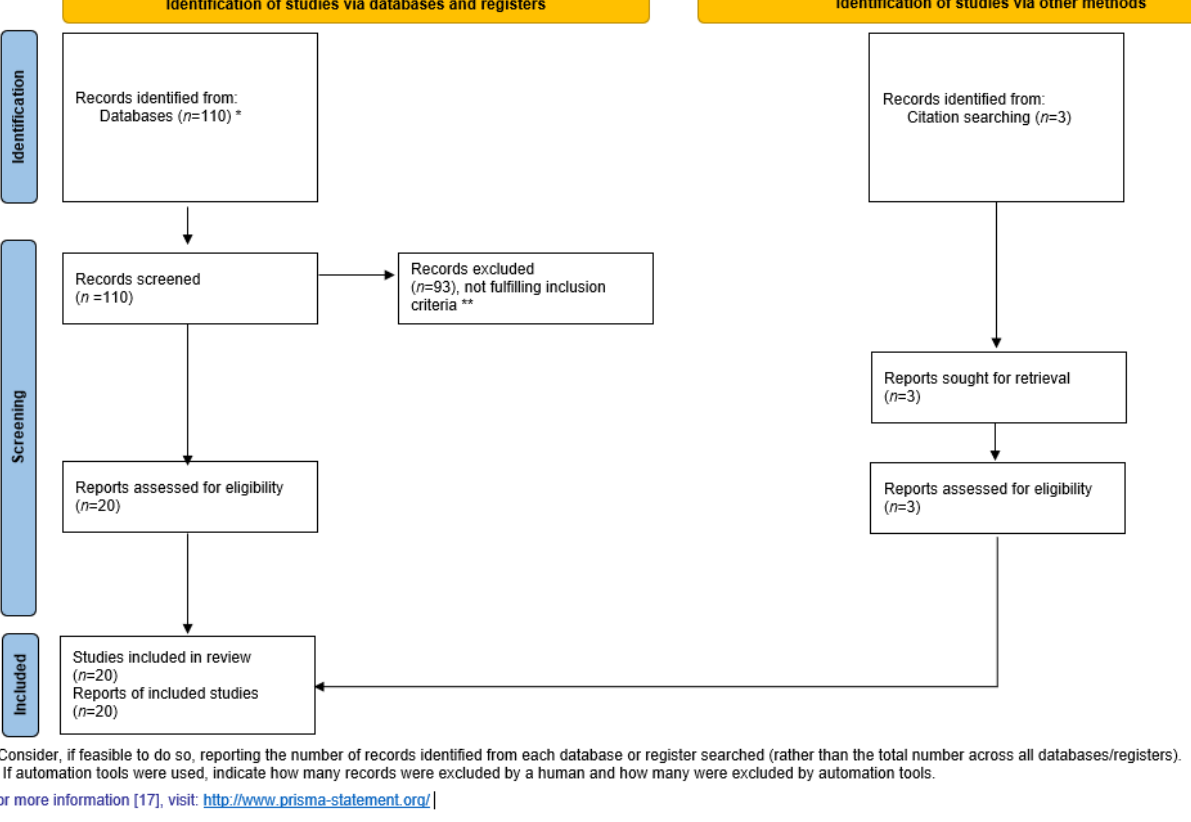
Figure 2. PRISMA 2020 flow diagram for new systematic reviews, which included searches of databases, registers, and other sources.